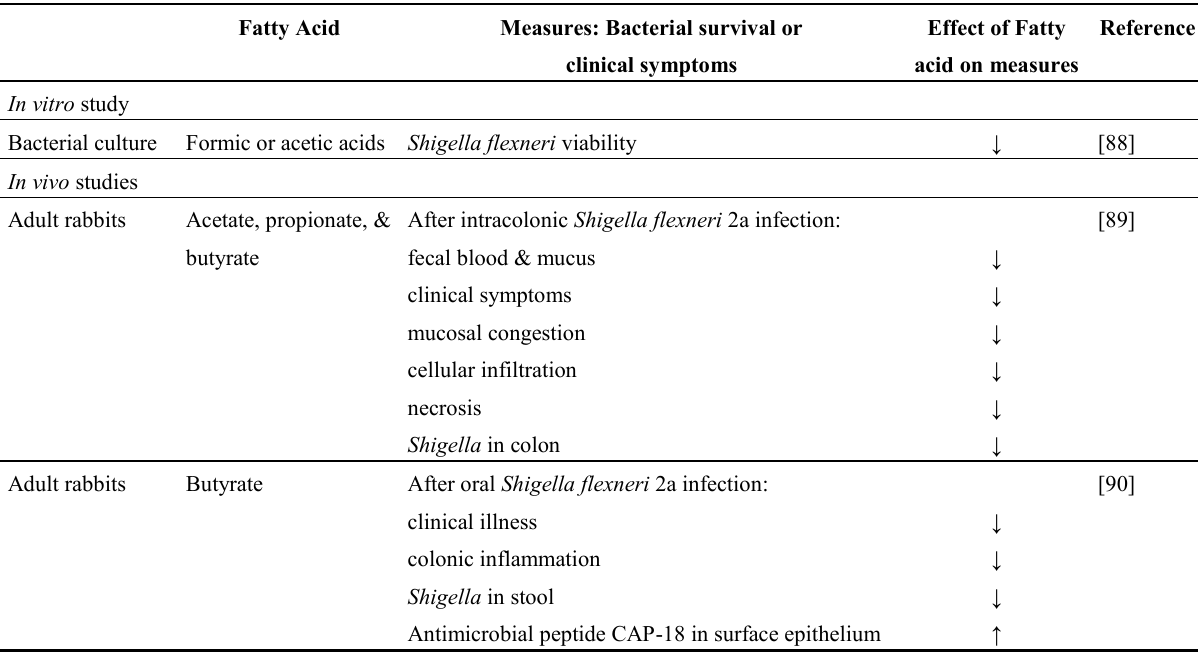
Table 4. Impact of dietary fatty acids on Shigella viability and